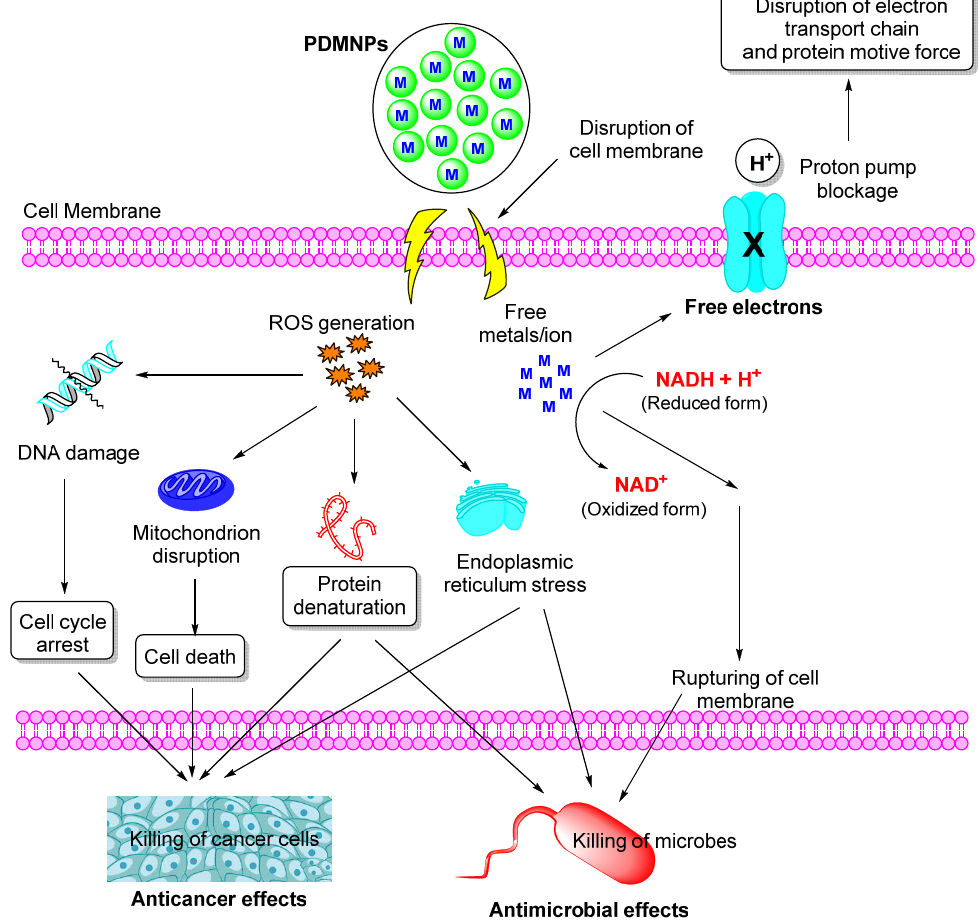
Figure 5. The representation of pathways involved in oxidative stress-mediated anticancer and an- timicrobial properties given by PDMNPs.